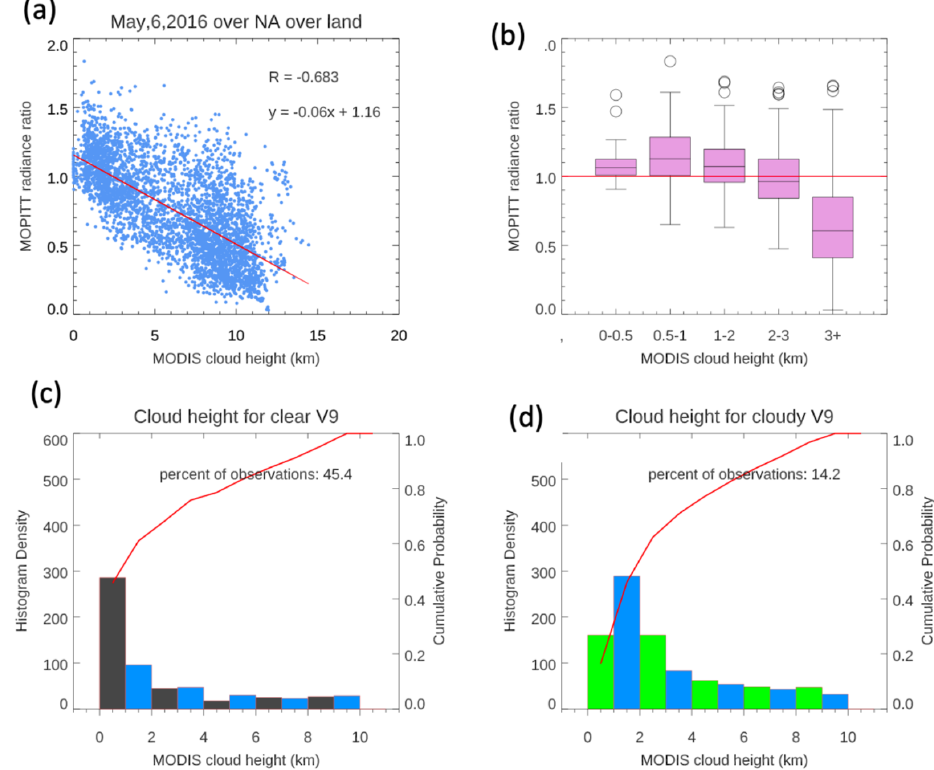
Figure 9. (a) Scatter plot correlation between MOPITT radiance ratio (MRT) and MODIS cloud height, (b) a box-and-whisker plot of MRT and various MODIS cloud height groups, (c) the histogram density of MODIS cloud heights of MOPITT clear/MODIS clear observations, and (d) the histogram density of MODIS cloud heights of MOPITT clear/MODIS cloudy observations on 6 May 2016.